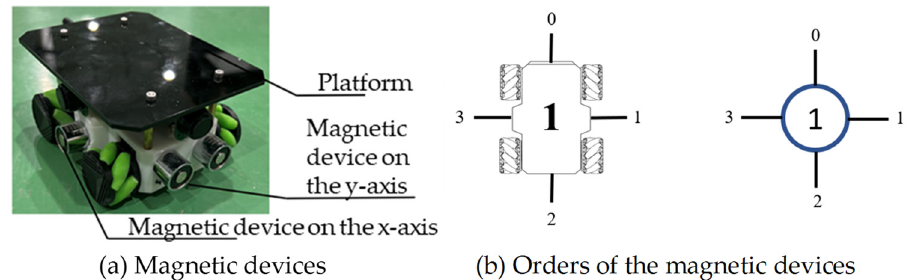
Figure 2. Electric-driven magnetic structure.